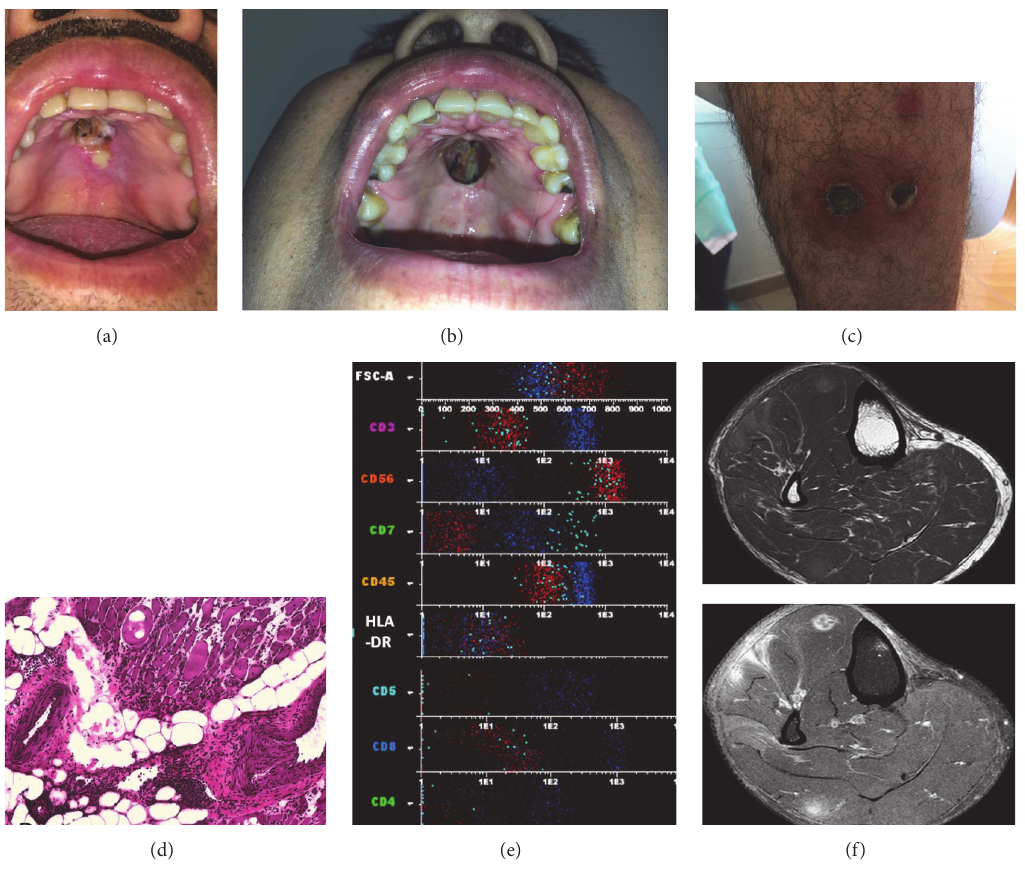
Figure 1: (a-b) Nasal lymphoma showing an initial ulcer that perforated into the oral cavity, opening a passage between the oral cavity and the nasal cavity. (c) Cutaneous manifestation of nasal-type extranodal NK/T-cell lymphoma. (d) Skeletal muscle fascicles revealing markedly distorted overall architecture with inflammatory interstitial infiltrate and endo and perimysial expansion. Perivascular lymphocytic inflammatory cluster with no signs of vasculitis. Myopathic changes suggestive of inflammatory myopathy. EBERnegative. (e) Flow cytometry analysis of vitreous humor specimen: analysis is performed on cells consistent with leukocytes by FSC versus SSC and CD45. Flow cytometry demonstrates an aberrant NK-cell population (highlighted in red) with the following immunophenotype: CD3s − , CD56 (bright), CD7 − , CD45+, HLA-DR − , CD5 − , CD8 − , and CD4 − (see complete immunophenotype in text). Cells highlighted in cyan show a minor population of not aberrant NK cells and cells in red show reactive T cells. (f) MRI of the lower limbs revealing myositis infectious between the extensor digitorum longus and peroneus